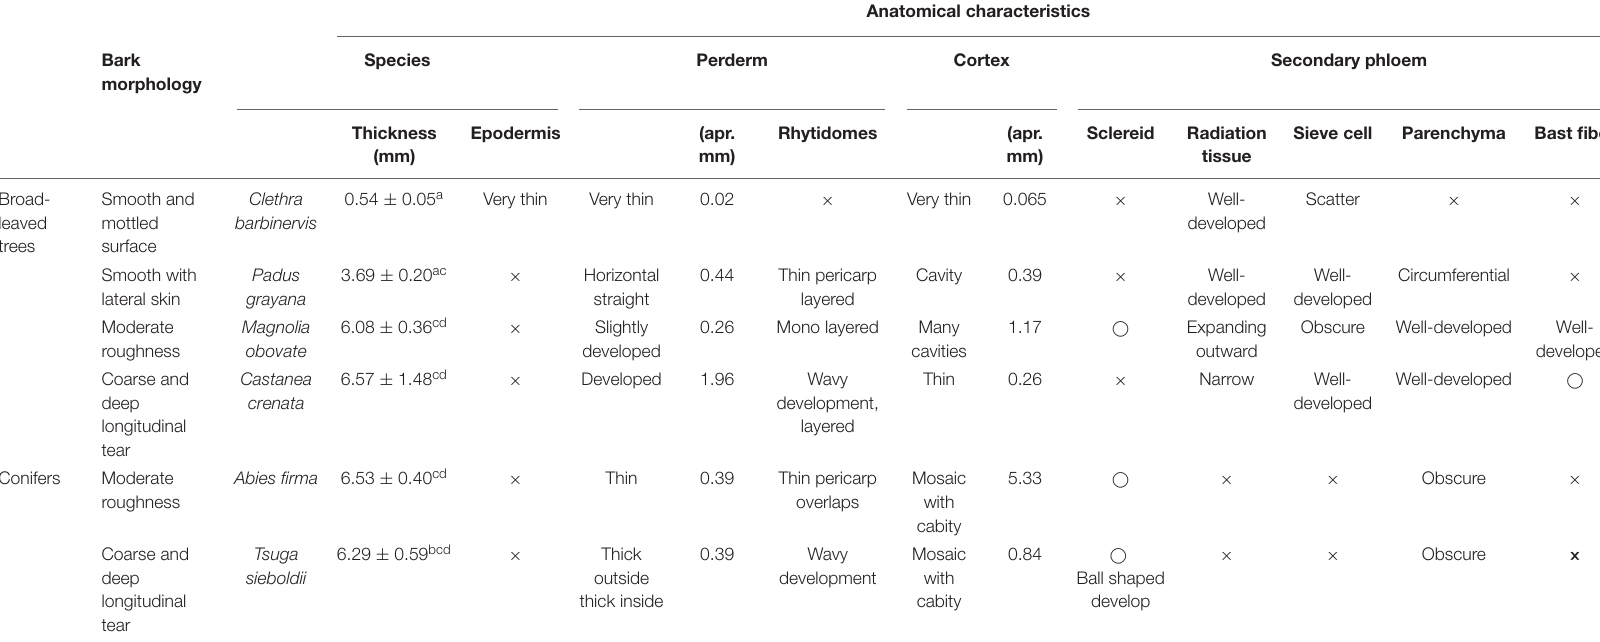
TABLE 3 | Summarized of anatomical characteristics of each